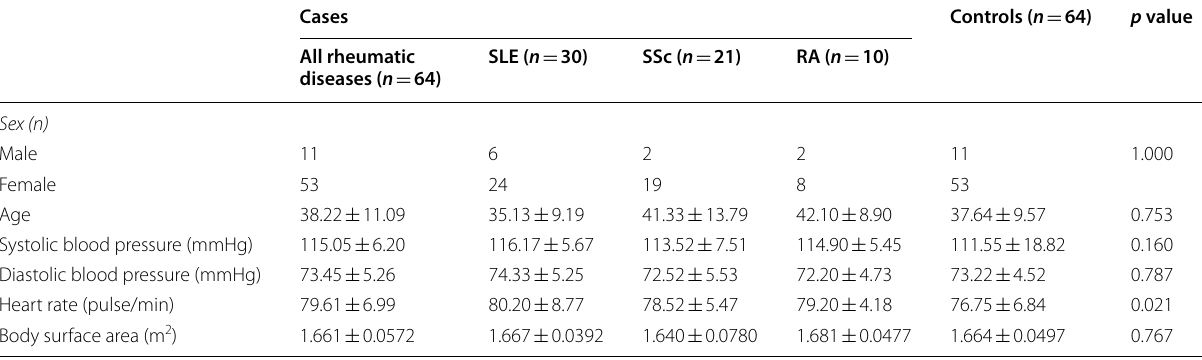
Data are represented as mean standard deviation for continuous variables ± SLE systemic lupus erythematosus, SSc systemic sclerosis, RA rheumatoid arthritis